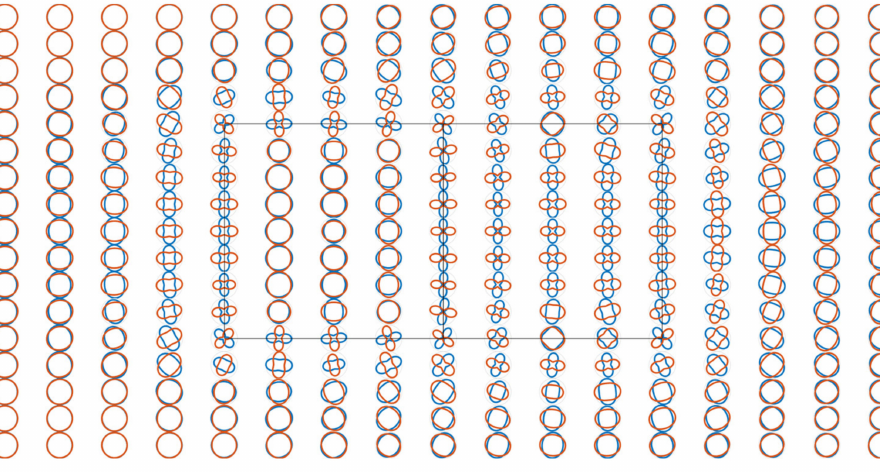
Figure 19. Polar plots of COMMEMI 3D-2A model for a frequency of 0.01 Hz. As for the anisotropy case, relatively large ratios of major axis to minor axis of polar plots are only yielded at sites above anomalous prisms at a frequency of 0.1 Hz (Figure 21). For frequencies of 0.01 Hz and 0.001 Hz, polar plots indicating anisotropy extend from the sites above anomalous prisms to the host earth, as shown in Figures 22 and 23, because they are affected by the second anisotropic layer. A comparison of the anisotropy index and polar plot for the three frequencies shows that high values of the former focus on anomalous prisms, while the latter with a large ratio of the major axis to minor axis extends to the host earth gradually following a decrease in